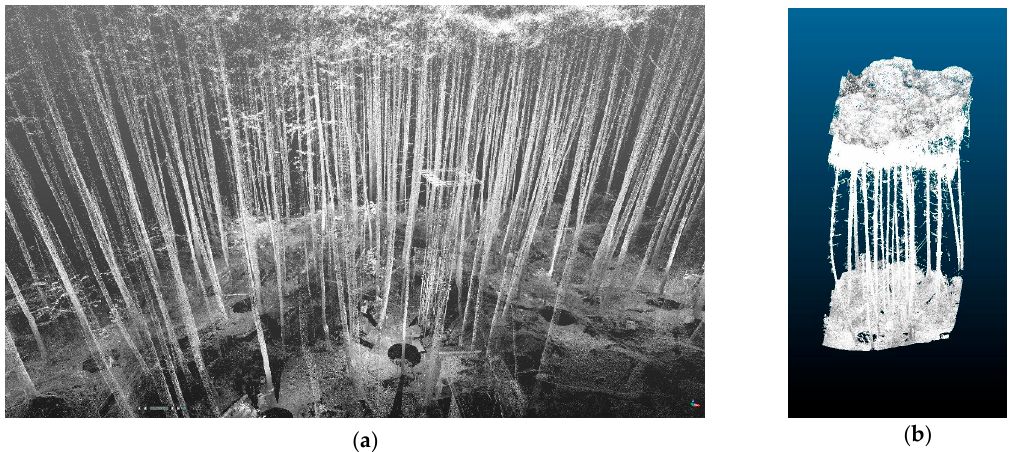
Figure 5. ( a ) Merged TLS scans of the study site, and ( b ) example of the extracted sample area with the 10 by 10 m grid size. Each individual tree was measured to compute tree height and diameter at breast height (DBH) within the grids.